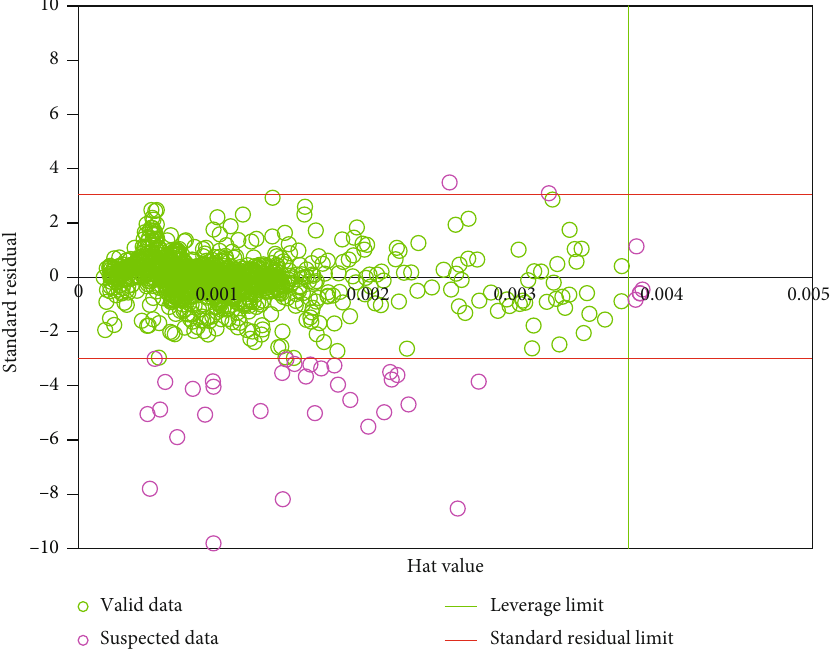
Figure 2: Williams plot and analysis of data to determine suspicious